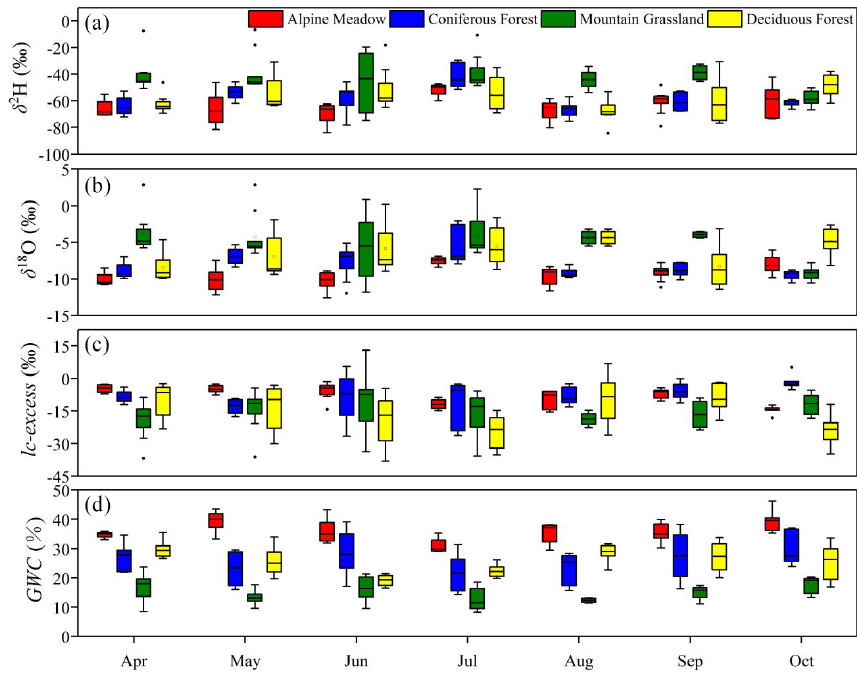
Figure 6. The variation of δ 2 H, δ 18 O, lc-excess and GWC in different vegetation zones in each sampling.